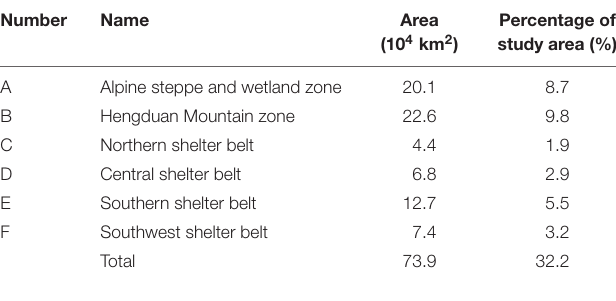
TABLE 1 | Area and percentage statistics of ecological security patterns in Southwest